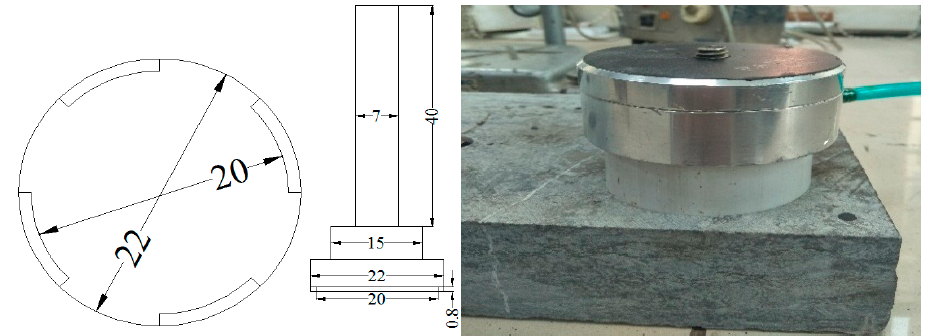
Figure 7. Dimensions of stub (mm) used in BBS test and piston setup.